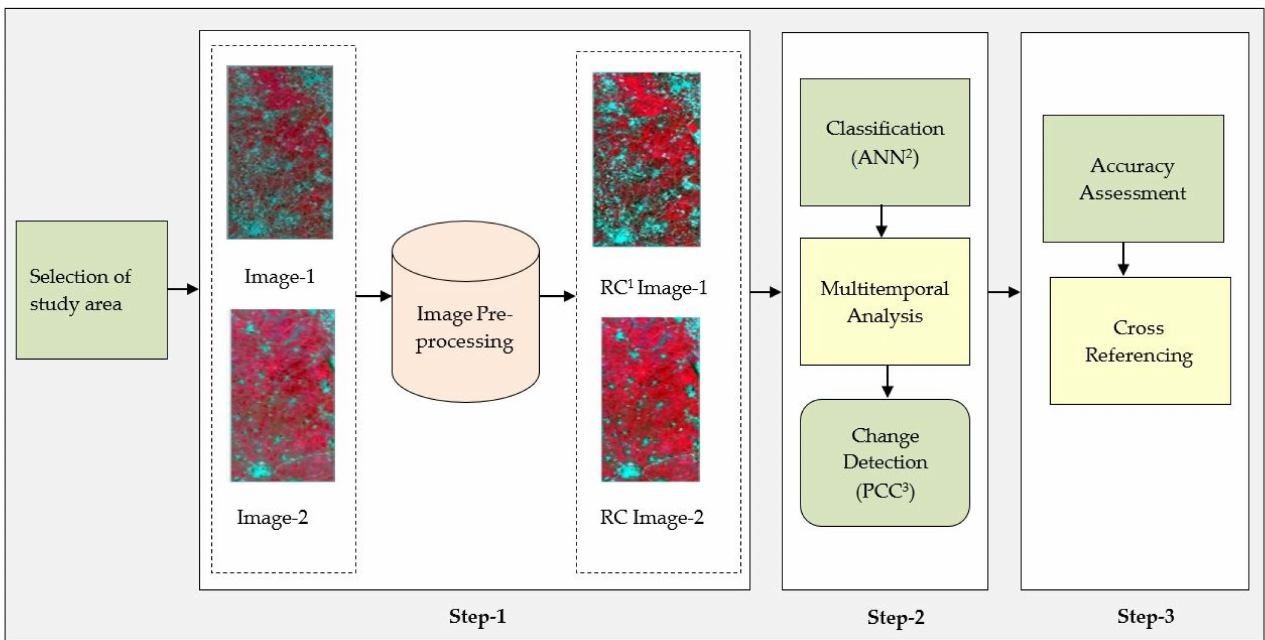
Figure 3. The flowchart of the proposed methodology. Note: 1 RC: Radiometric Correction; 2 ANN: Artificial Neural Network; 3 PCC: Post Classification